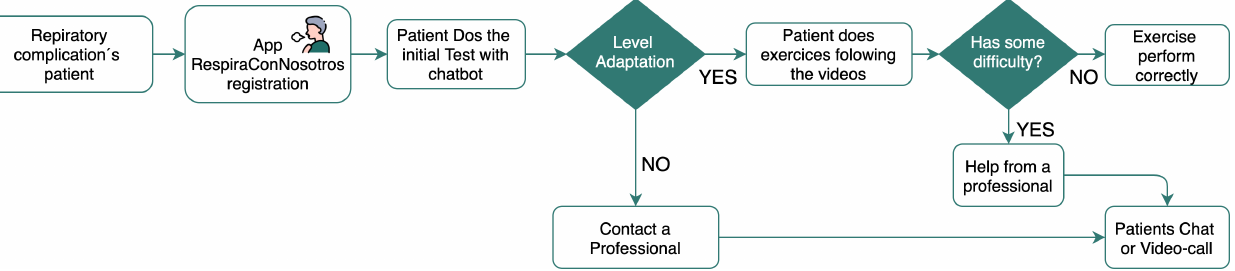
Figure 6. Chat tabs.